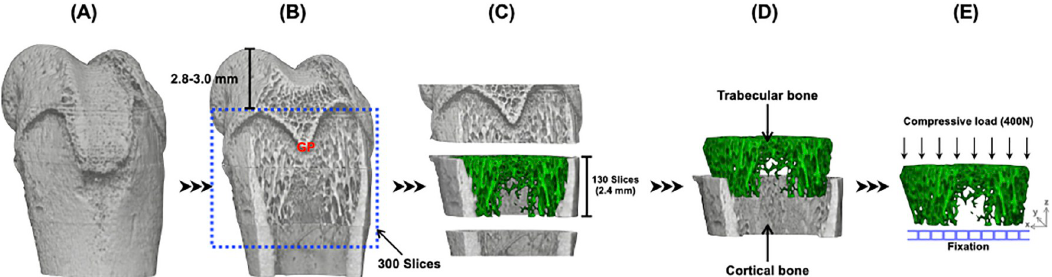
Fig 1. Micro-CT analyses of trabecular bone microarchitecture in the distal femoral metaphysis. A) Representative 3D images of the femoral trabecular bone architecture scanned by micro-CT. B) The distal femoral metaphysis was scanned in an area 2.8–3.0 mm proximal to the distal end of the femur, including the border between the metaphysis and growth plate (GP). C) The region of interest selected for analysis, including cortical and trabecular bone of the distal femoral metaphysis (130 slices). D) Cortical and trabecular bone were subsequently separated and 3D structural indices were calculated. E) After analyzing the trabecular bone architecture, samples were subjected to FEA for prediction of fracture loads. The nodes located at the proximal surface of the femur was fully fixed in all directions, and compression test was simulated at a load of 400N applied to the distal surface of the